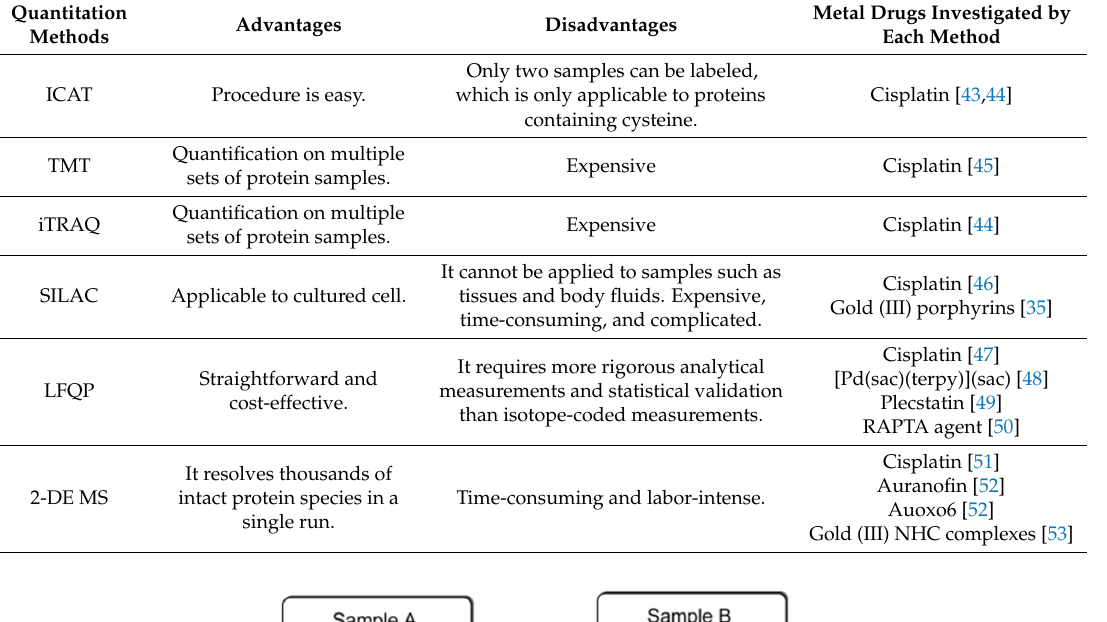
Table 1. Comparison of commonly used methods in quantitative proteomics.